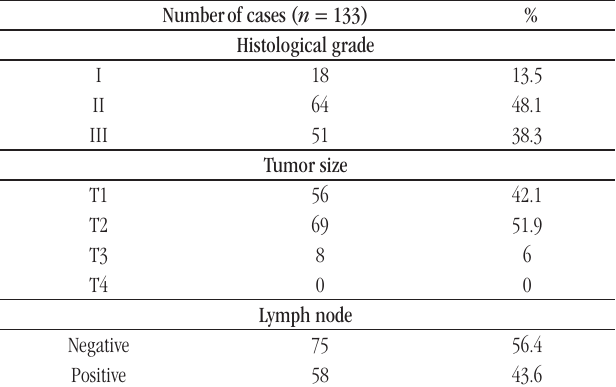
taBLE 3 − Distribution of the sample in relation to histological grade, tumor size, and lymph node